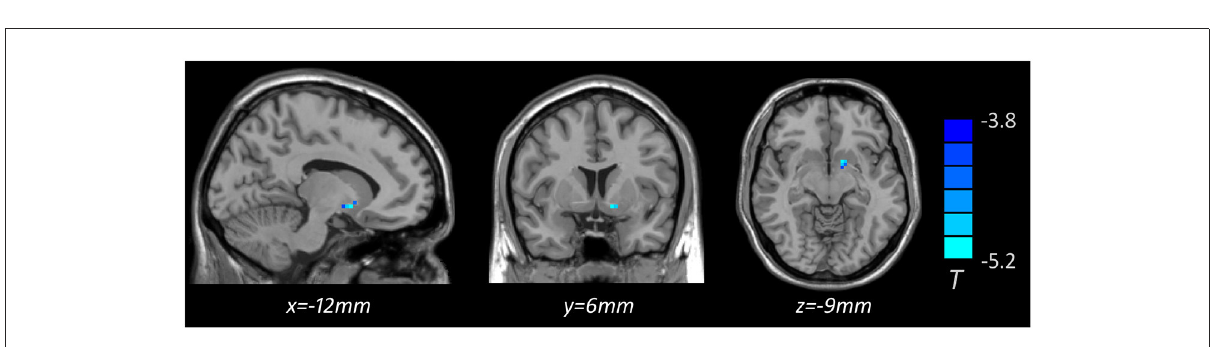
FIGURE4 Brain region showing decreased gray matter volume associated with plasma level of IL-6 (pg/ml) in MDD with anhedonia ( p < 0.05, GRF corrected ). The color scale represents t